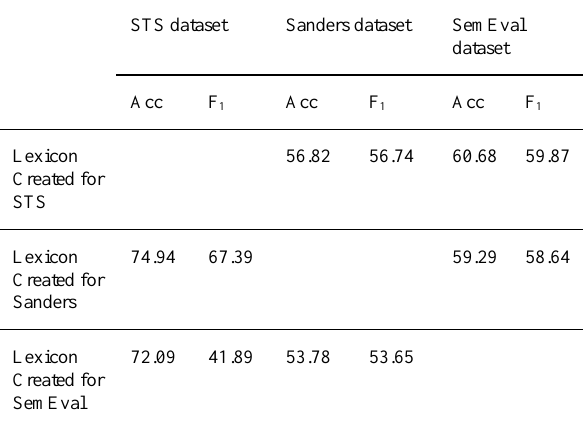
Table 6. Performance of cross-transfer subjectivity